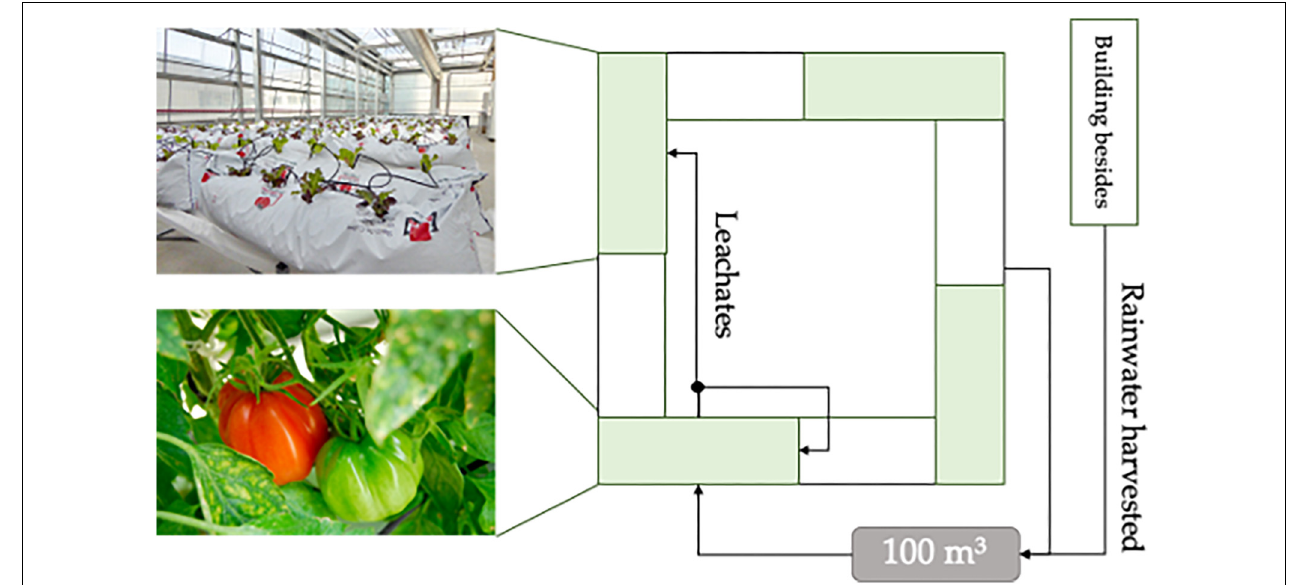
FIGURE 1 | Diagram of the cascade